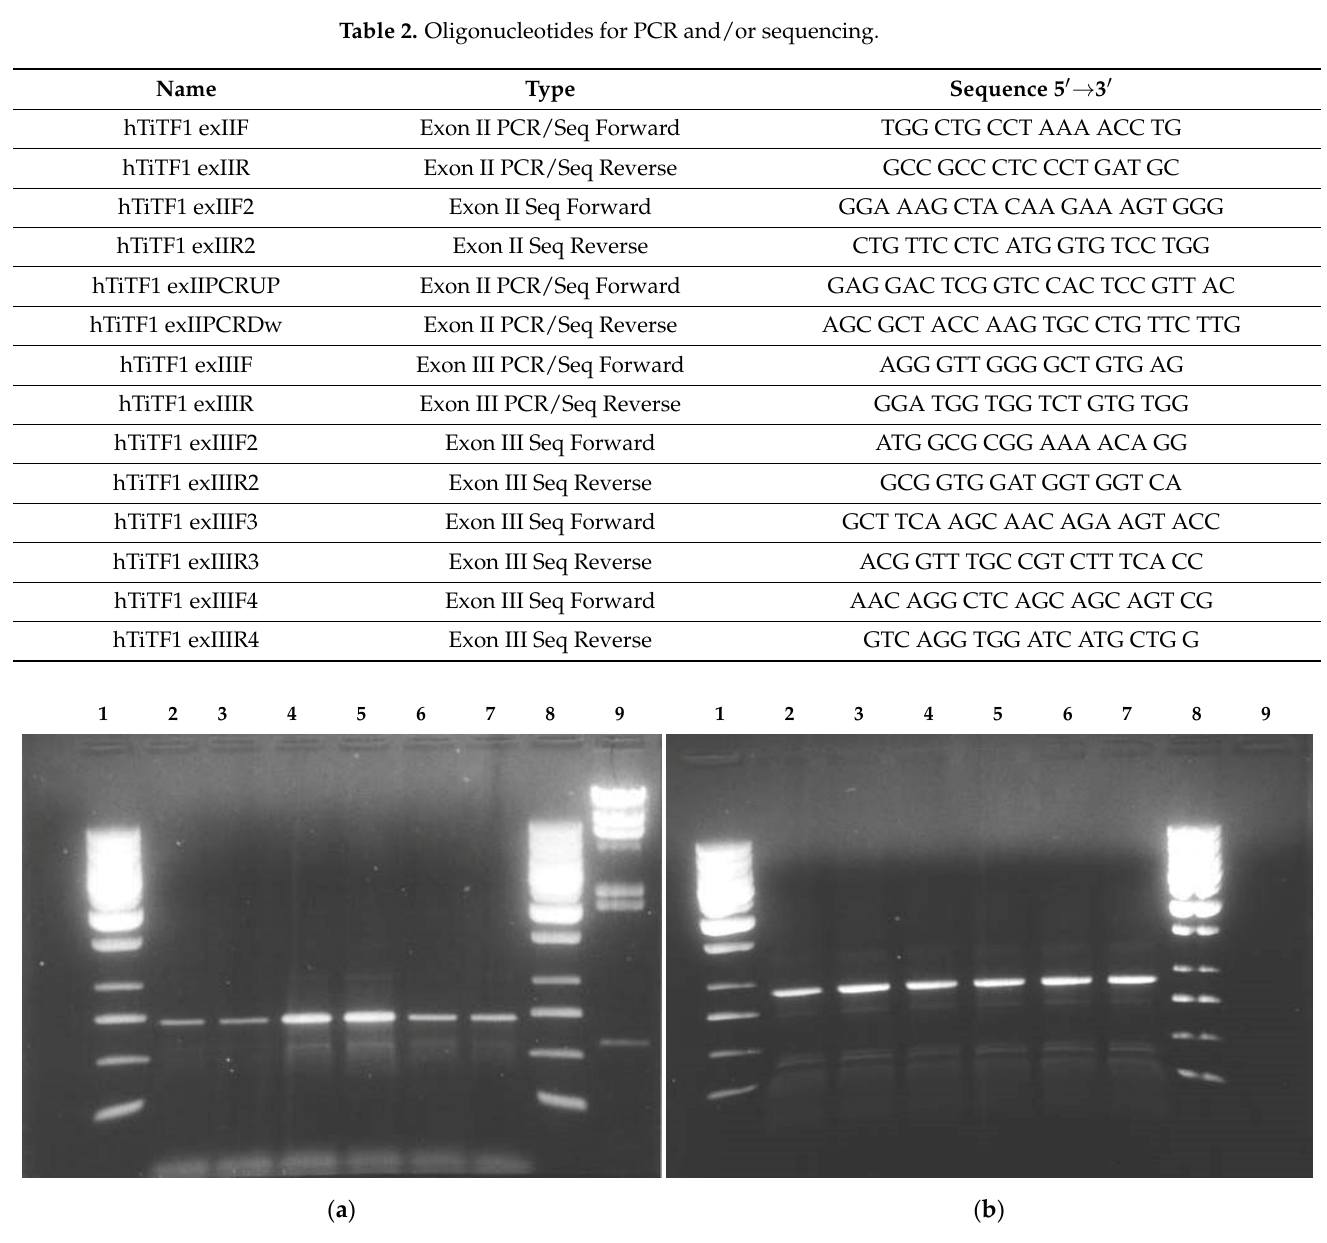
Figure 2. PCR amplification of exons, representative samples: ( a ) from left: lane 1 size molecular